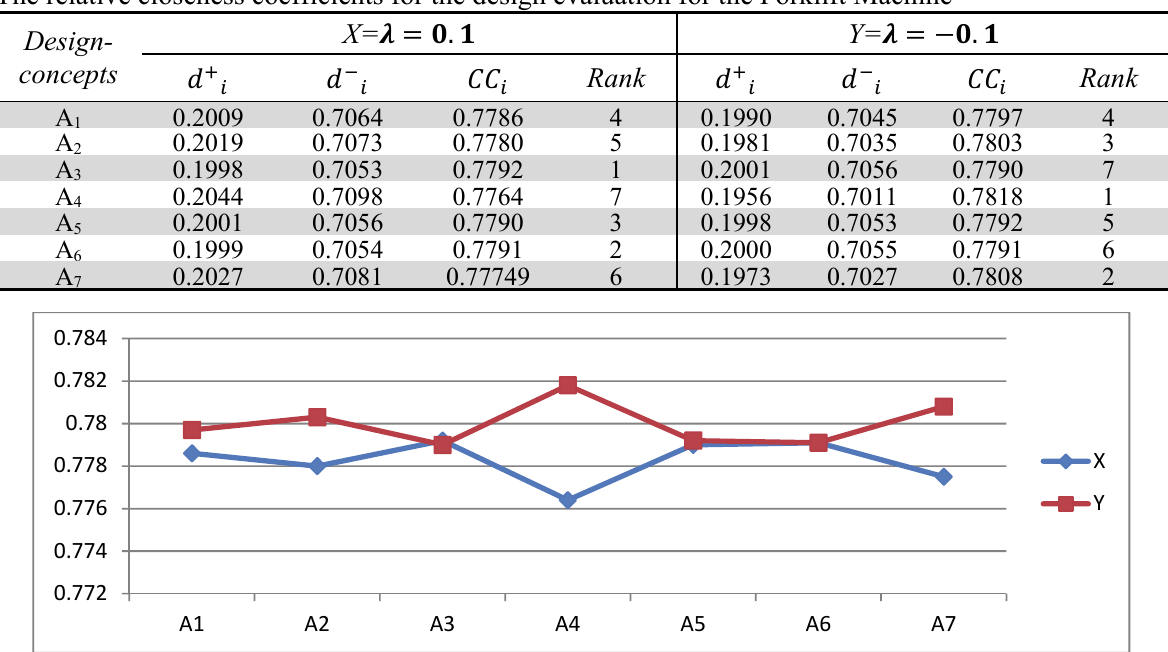
Fig. 3. Graphical representation of the design concept